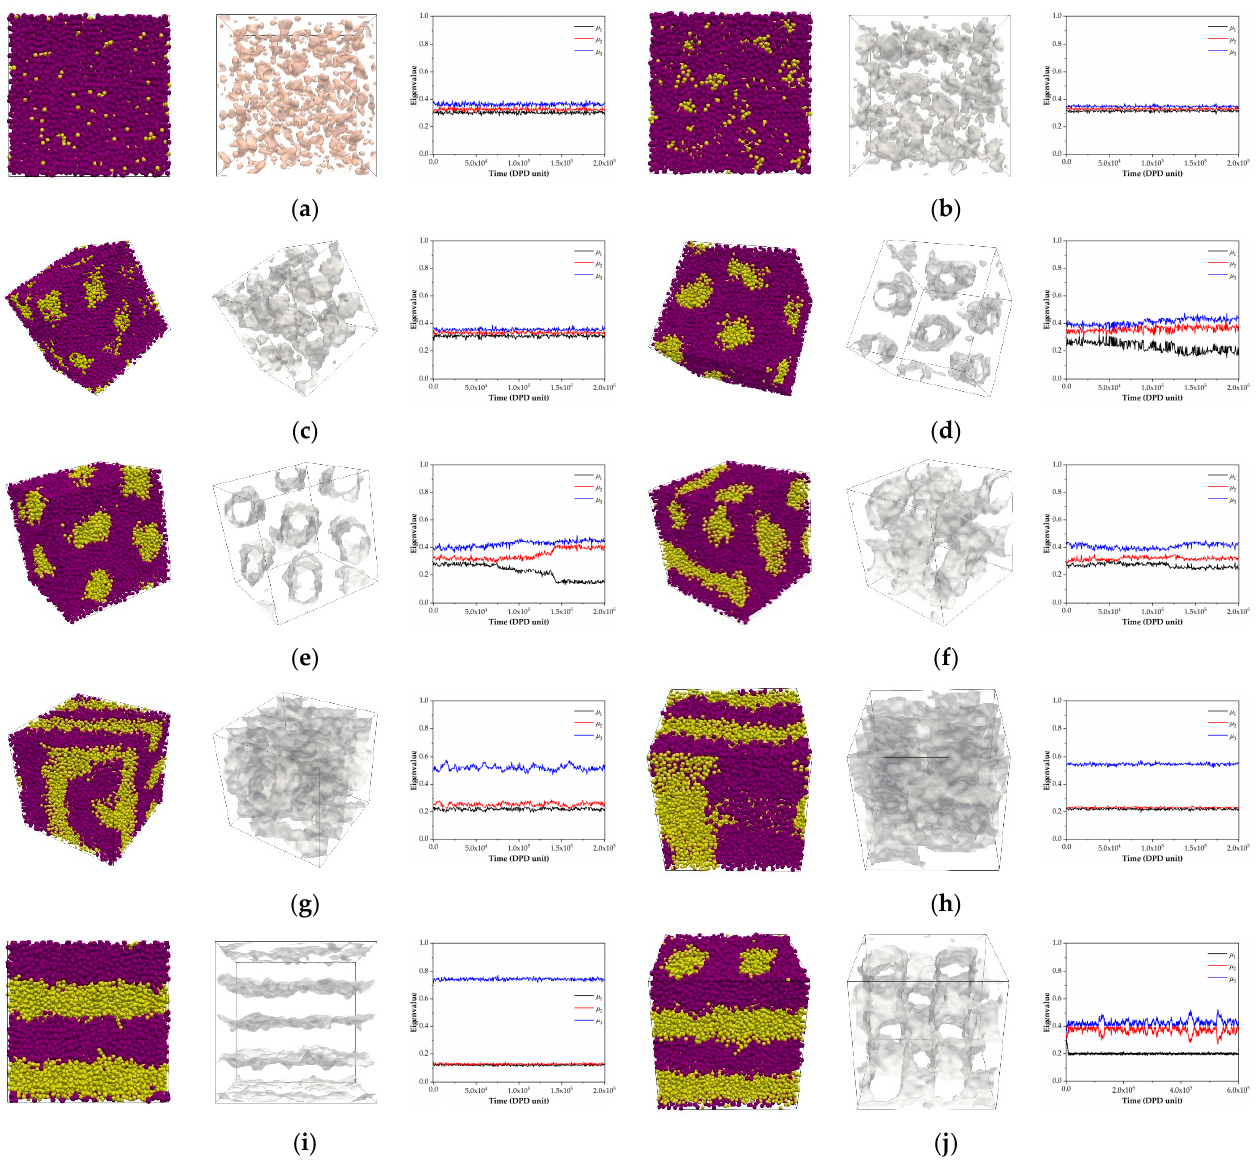
Figure 6. Panels in the composite figures illustrate apparent bead arrangements, isosurfaces between distinct bead types and the order-parameter sorting, from left to right, of ( a ) S 1 I 19 , ( b ) S 2 I 18 , ( c ) S 3 I 17 , ( d ) S 4 I 16 , ( e ) S 5 I 15 , ( f ) S 6 I 14 , ( g ) S 7 I 13 , ( h ) S 8 I 12 , ( i ) S 9 I 11 and ( j ) S 10 I 10 , respectively. The order parameters were calculated using an executable, namely isosuefaces.exe, an implemented tool in the DL_MESO software. Yellow and violet beads represent coarse-grained beads of styrene and isoprene, respectively. Table 2. Coarse-grained models and their morphological classification.